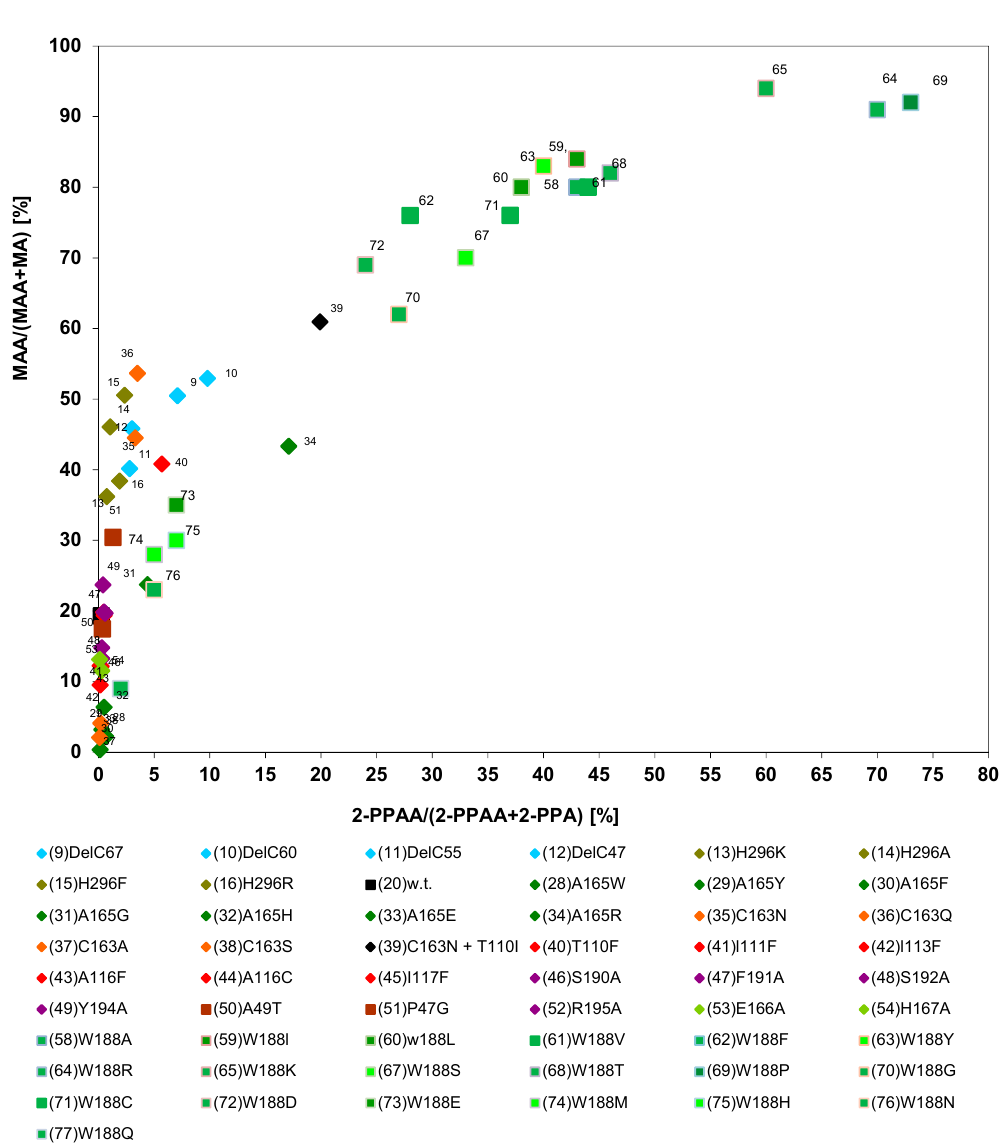
Figure 7. Correlation between the amounts of amides formed from ( R , S )-mandelonitrile and ( R , S )-2-phenylpropionitrile by different nitrilase variants. The data were taken from previous publications (see Figure 6).